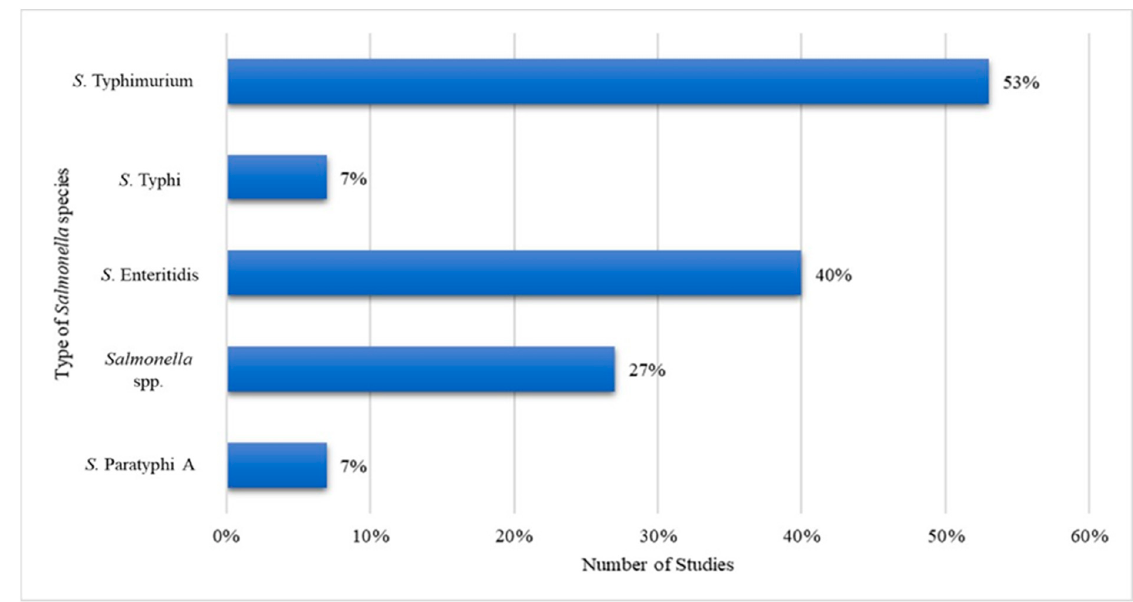
Figure 3. Salmonella bacteria from various species detected via nucleic-acid-based colorimetric method.